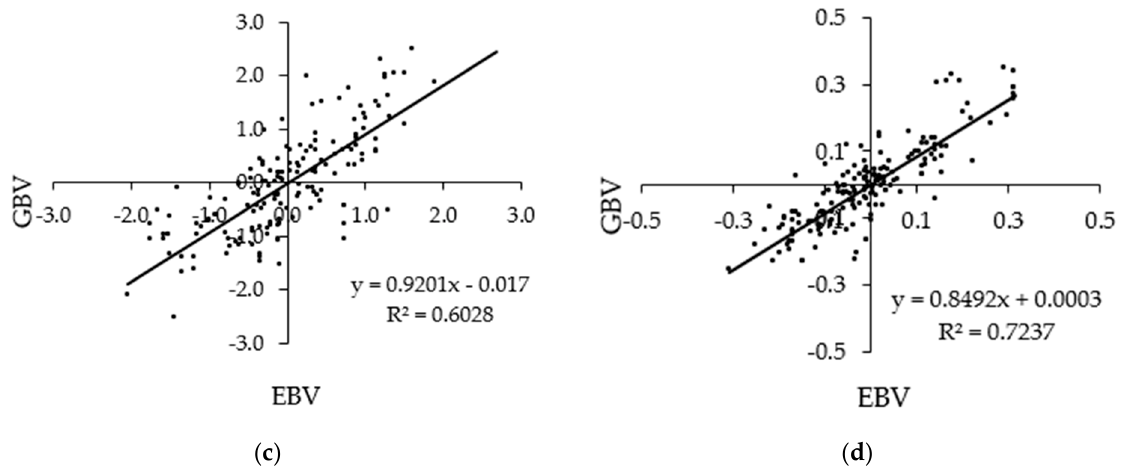
Figure 2. Scatterplot of standardized GBVs against standardized EBVs of the ( a ) milk yield, ( b ) fat yield, ( c ) protein yield, and ( d ) somatic cell score of animals in the validation set that has both the sire and dam recorded, n = 161.